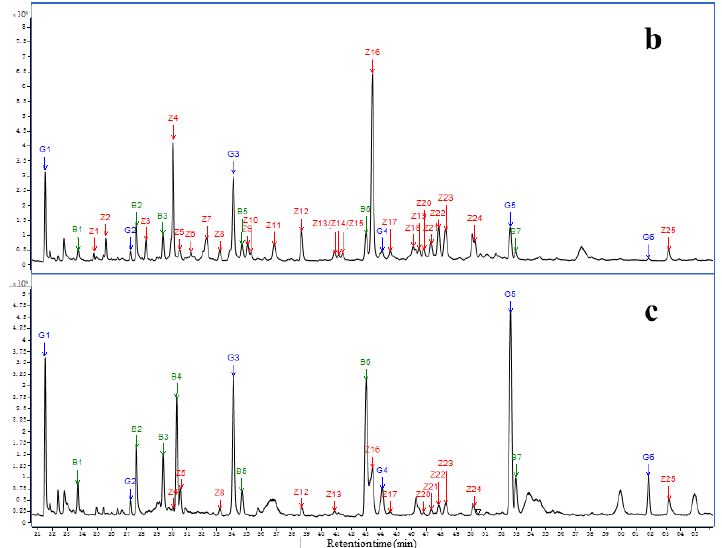
Figure 6. GC-MS chromatograms of HS-SPME extracts at the time points of 10 min for serum samples: ( a ) control group, ( b ) intraperitoneal injection group, ( c ) inhalation group.